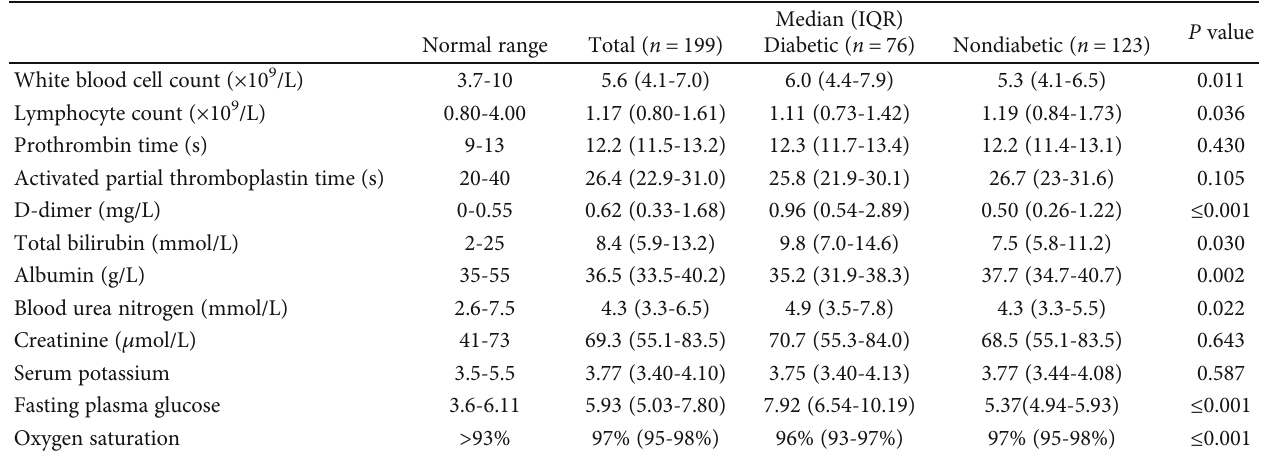
Table 2: Laboratory fi ndings of patients with COVID-19 at